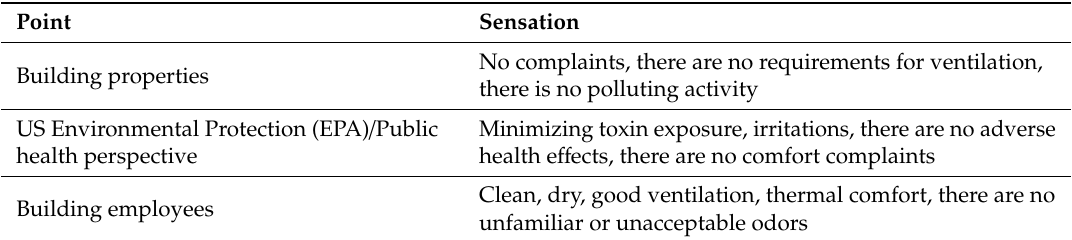
Table 1. The three acceptable perspectives of indoor air quality (IAQ)